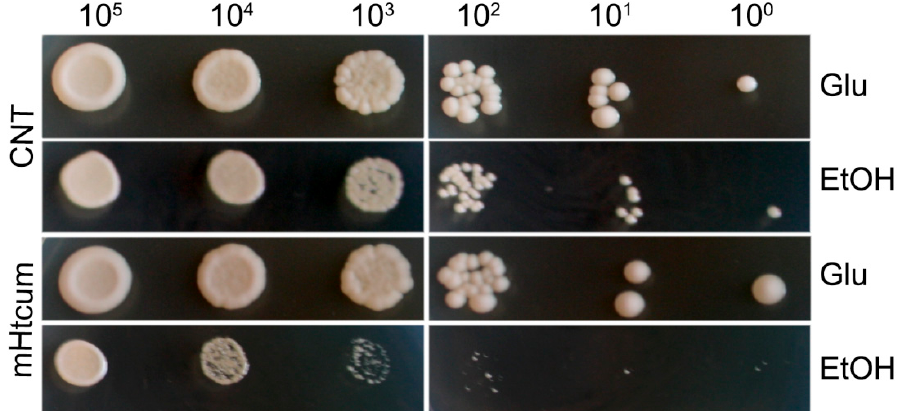
Figure 2. Yeast dilution bioassays showing the e ff ect of mHtcum under oxidative growth. Cells of W303-1B strain serially diluted and spotted on YP medium supplemented with glucose or ethanol and added with mHtcum 50 µ M or 0.5% DMSO